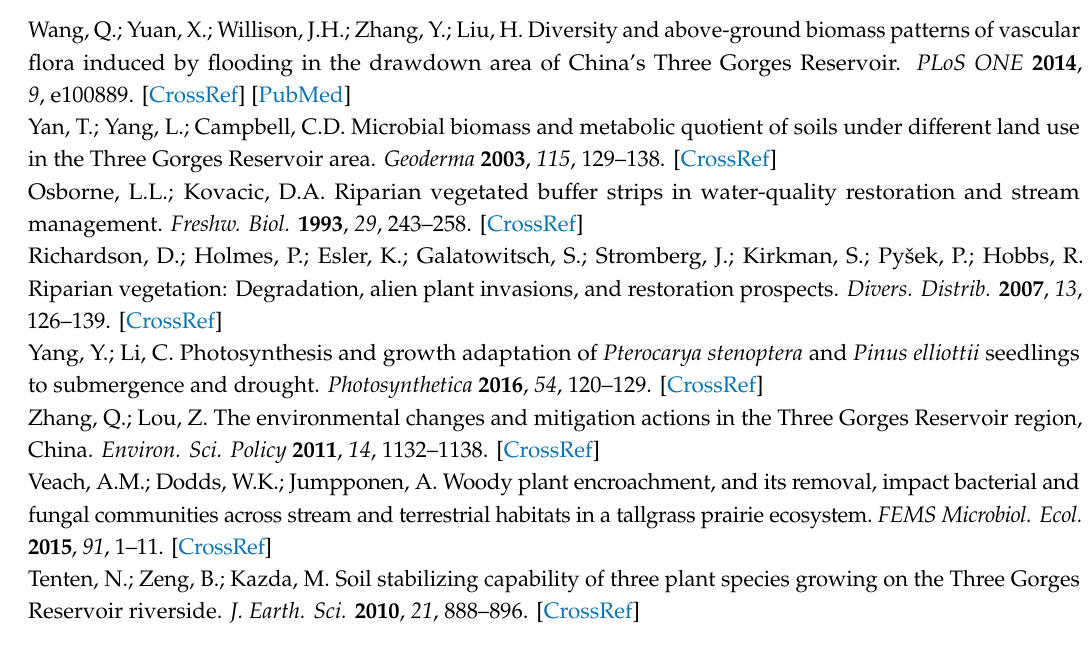
s1. Figure S1 Neighbor-joining phylogenetic tree (Maximum Likelihood method) showing the relationships of the representative sequences of OTUs and the reference sequences from GenBank and UNITE; Figure S2 The temperature (a) and rainfall (b) of the sampling sites in the Three Gorges Reservoir from Feb (February) to Nov (November) in 2014; Table S1 Specific information on the sampling sites; Table S2 Relative abundance of arbuscular mycorrhizal fungi (AMF) taxa in the rhizosphere soils of Cynodon dactylon in three contrasting land use types along the drawdown zone of the Three Gorges Reservoir; Table S3 Relative abundance (%) of arbuscular mycorrhizal fungi (AMF) taxa in roots associated with Cynodon dactylon grown in three contrasting land use types along the drawdown zone of the Three Gorges Reservoir; Table S4 Correlation coe ffi cient between arbuscular mycorrhizal fungi (AMF) community composition and environmental variables (soil chemical characteristics and land-use type) from axes 1 and 2 of ordination; Table S5 Permutational multivariate analysis of